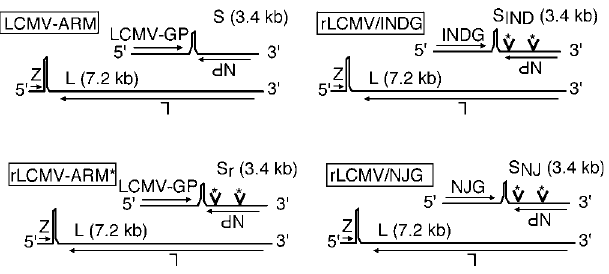
Figure 1. Wild-Type and Recombinant Viruses Used in this Study All LCM viruses used in this study contain an identical L segment encoding for the LCMV RNA-dependent RNA polymerase (L ORF) and for the matrix protein Z. All four viruses also encode for an identical NP translation product. The three partially cDNA derived viruses (rLCMV/ INDG, rLCMV/NJG, and rLCMV-ARM*) carry, however, two noncoding genetic tags in the NP ORF as indicated (*; see also Figures 4 and S6). The LCMV-GP ORF of LCMV-ARM and rLCMV-ARM* is substituted for INDG and NJG in rLCMV/INDG and rLCMV/NJG, respectively. Arrows indicate the orientation of individual ORFs. Inverted writing (NP, L) indicates that in the viral genome, the respective ORFs are encoded in antisense polarity. DOI: